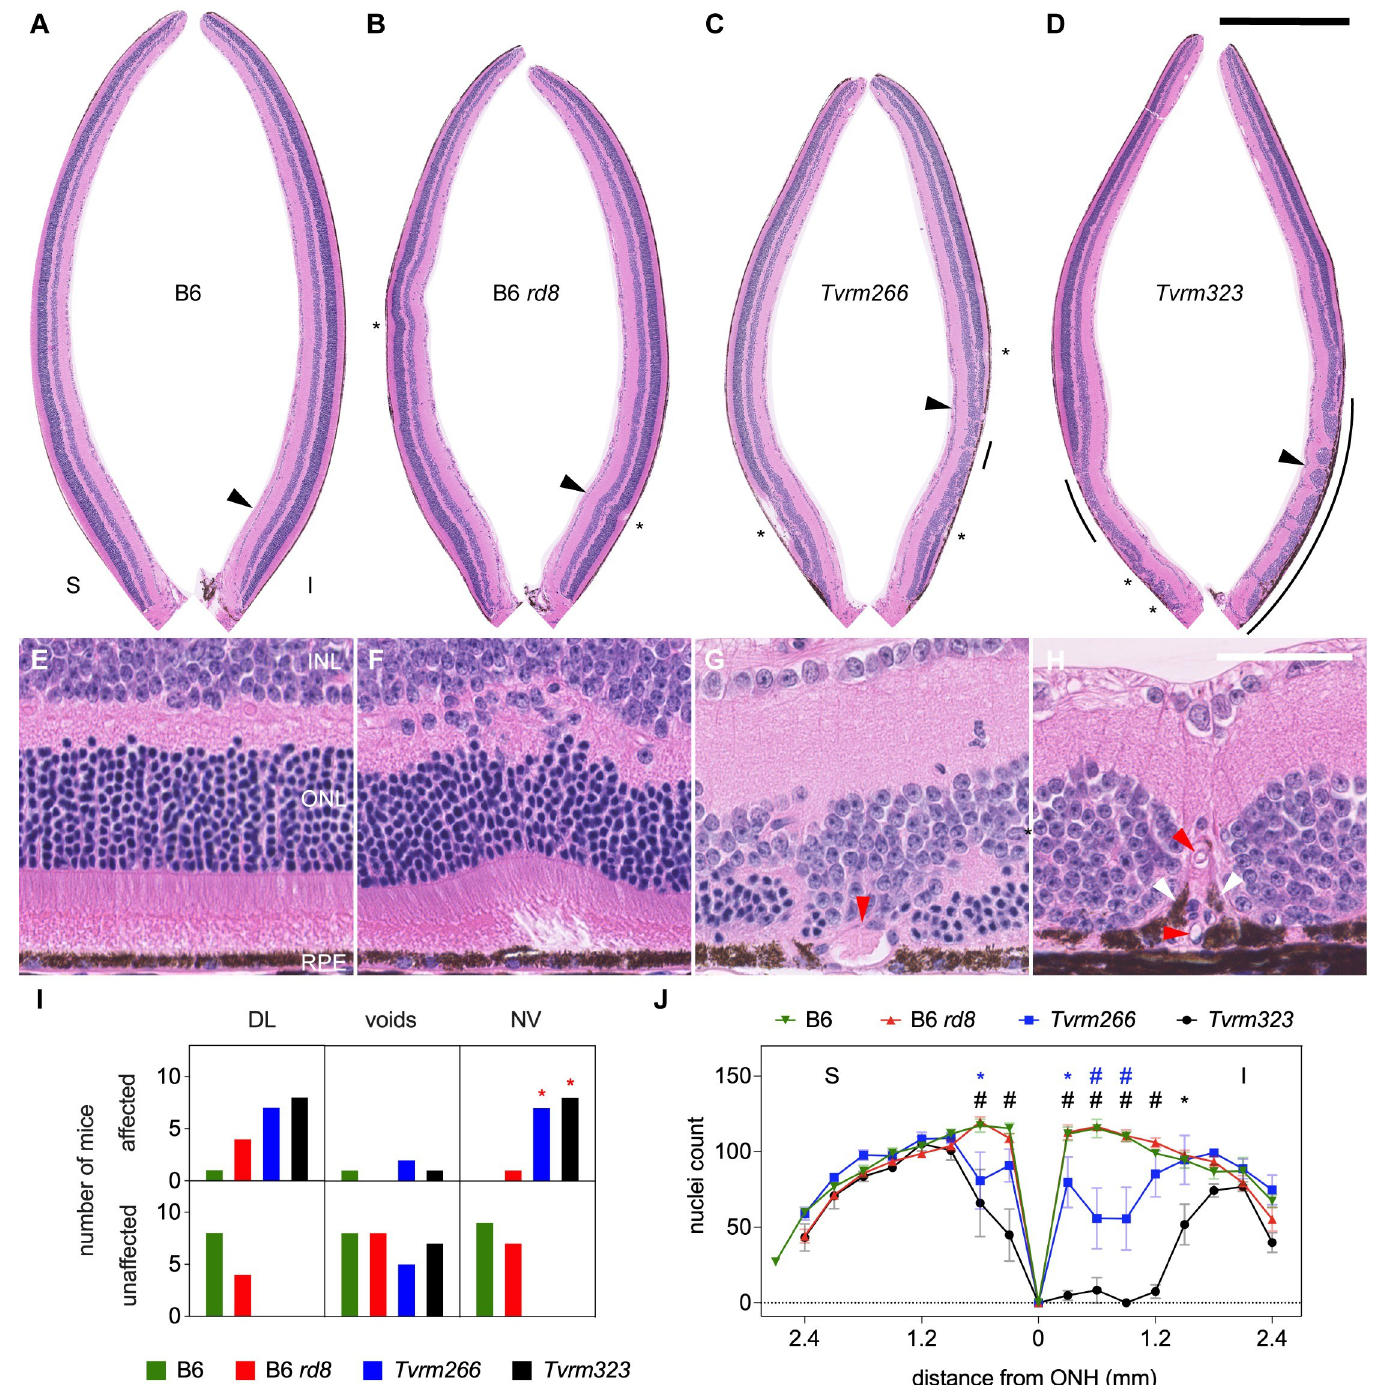
Fig 5. Histological analysis at 12 months of age. A–D. Superior (S) and inferior (I) retinas cropped from representative digital images of B6, B6 rd8 , Tvrm266 and Tvrm323 whole eye sections stained with hematoxylin and eosin and imaged with a slide scanner. Dysplastic lesions, asterisks . Areas devoid of photoreceptor nuclei, solid lines . Scale bar, 0.5 mm. Sites from A-D detailed in panels E–H, respectively, are marked by arrowheads . E. Normal retinal layers in B6 mice, labeled as in Fig 4. F. Dysplastic lesion in B6 rd8 . G, H. Photoreceptor loss at neovascular lesions ( red arrowheads ) in Tvrm266 , and Tvrm323 mice, respectively. In G, red blood cells are observed within a large vessel at the RPE. I. Incidence of pathological features among mice. Samples showing one or more of the identified features among 10–21 sections were scored as affected. DL, dysplastic lesions; NV, neovessels. Asterisks denote statistical significance (Fisher’s exact test against B6 rd8 mice, p < 0.05). J. Photoreceptor nuclei count within a 50 μ m length of retina as a function of distance from the ONH. Values represent mean ± SEM; n = 6–8. Statistical significance colored according to the strain compared to B6 rd8 in post hoc tests. p < 0.01, asterisk ; p < 0.0001, hash symbol . https://doi.org/10.1371/journal.pgen.1009798.g005 PLOS Genetics | https://doi.org/10.1371/journal.pgen.1009798 June 8,